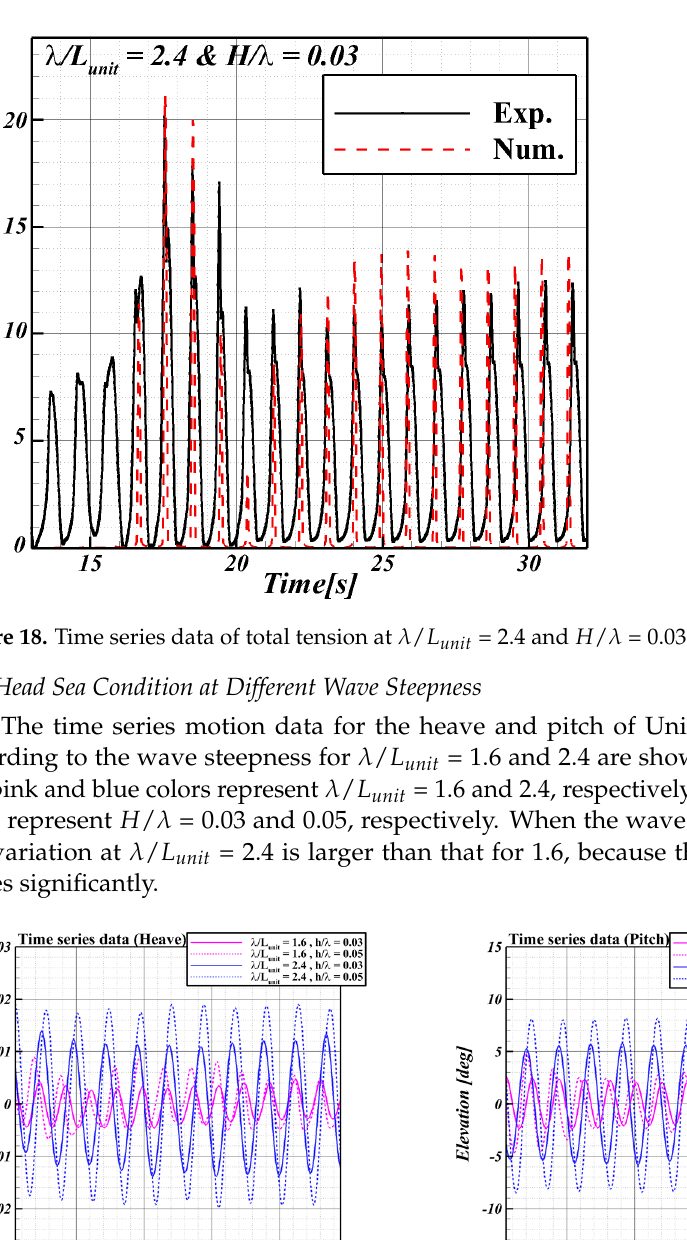
Figure 19. Time series motion data according to wave steepness at Unit 1: ( a ) heave; ( b ) pitch.